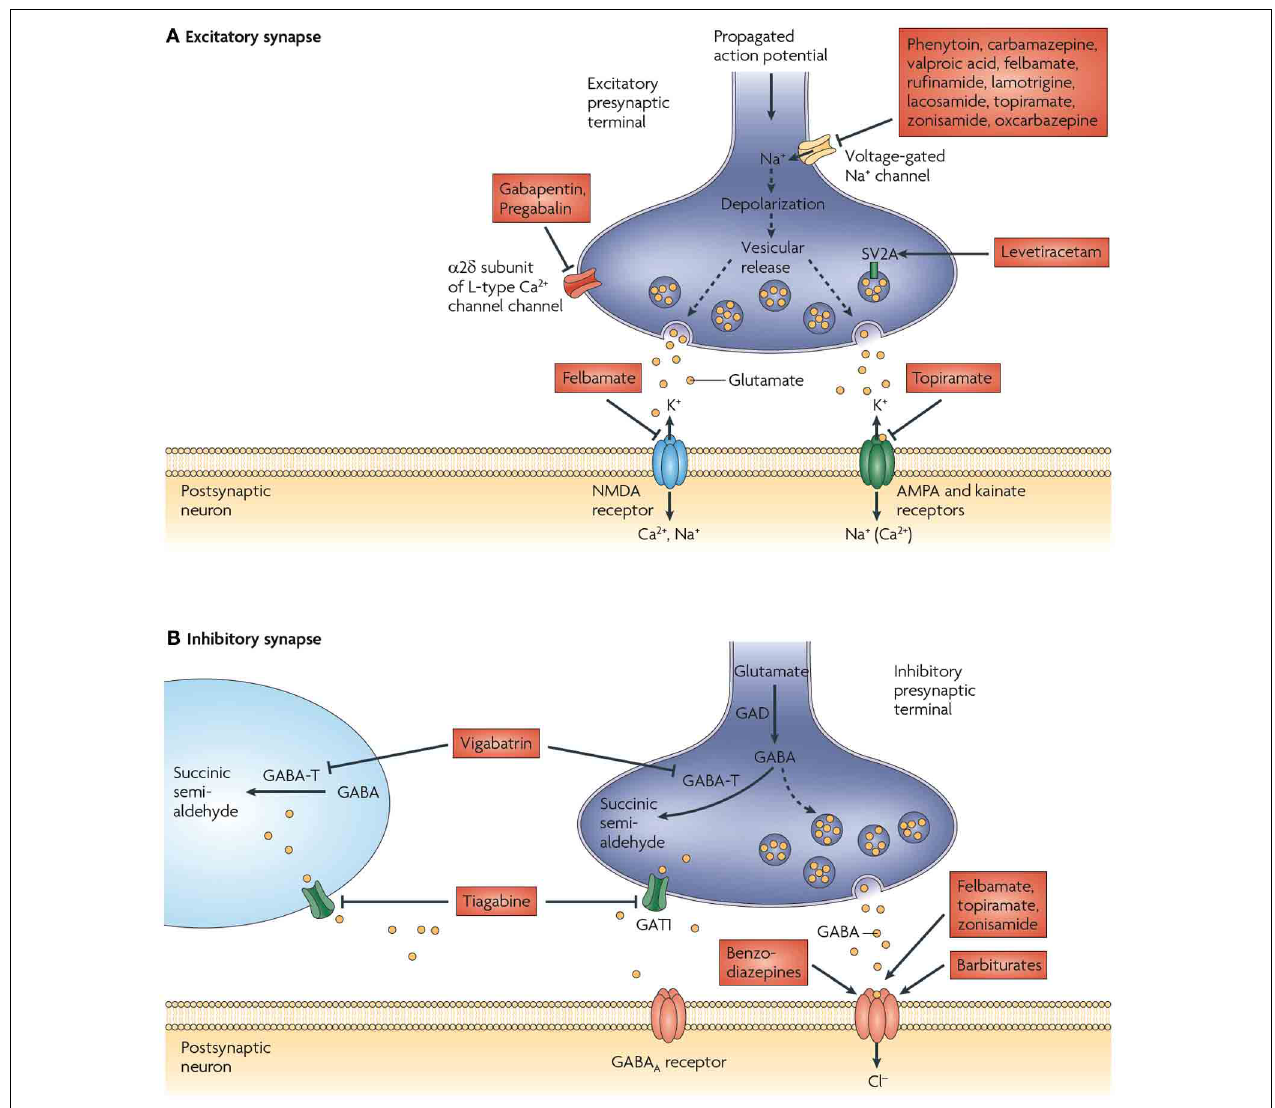
FIGURE 1 | Proposed mechanisms of action of currently available antiepileptic drugs (AEDs) at excitatory and inhibitory synapses. (A) Currently available AEDs are thought to target several molecules at the excitatory synapse. These include voltage-gated Na + channels, synaptic vesicle glycoprotein 2A (SV2A), the α 2 δ subunit of the voltage-gated Ca 2 + channel, AMPA ( α -amino-3-hydroxy-5-methyl-4-isoxazole propionic acid) receptors, and NMDA (N-methyl-d-aspartate) receptors. Many of the AEDs can modulate voltage-gated Na + channels. This would be expected to decrease depolarization-induced Ca 2 + influx and vesicular release of neurotransmitters. Levetiracetam is the only available drug that binds to SV2A, which might have a role in neurotransmitter release. Gabapentin and pregabalin bind to the α 2 δ subunit of voltage-gated Ca 2 + channels, which is thought to be associated with a decrease in neurotransmitter release. Excitatory neurotransmission at the postsynaptic membrane can be limited